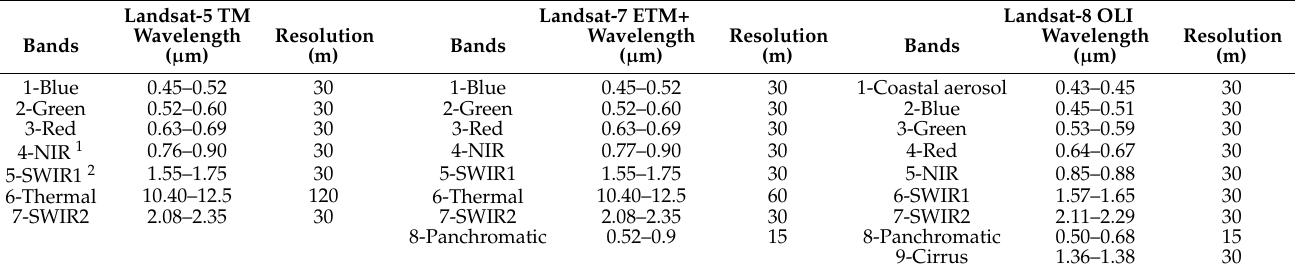
Table 1. Main parameters of the Landsat